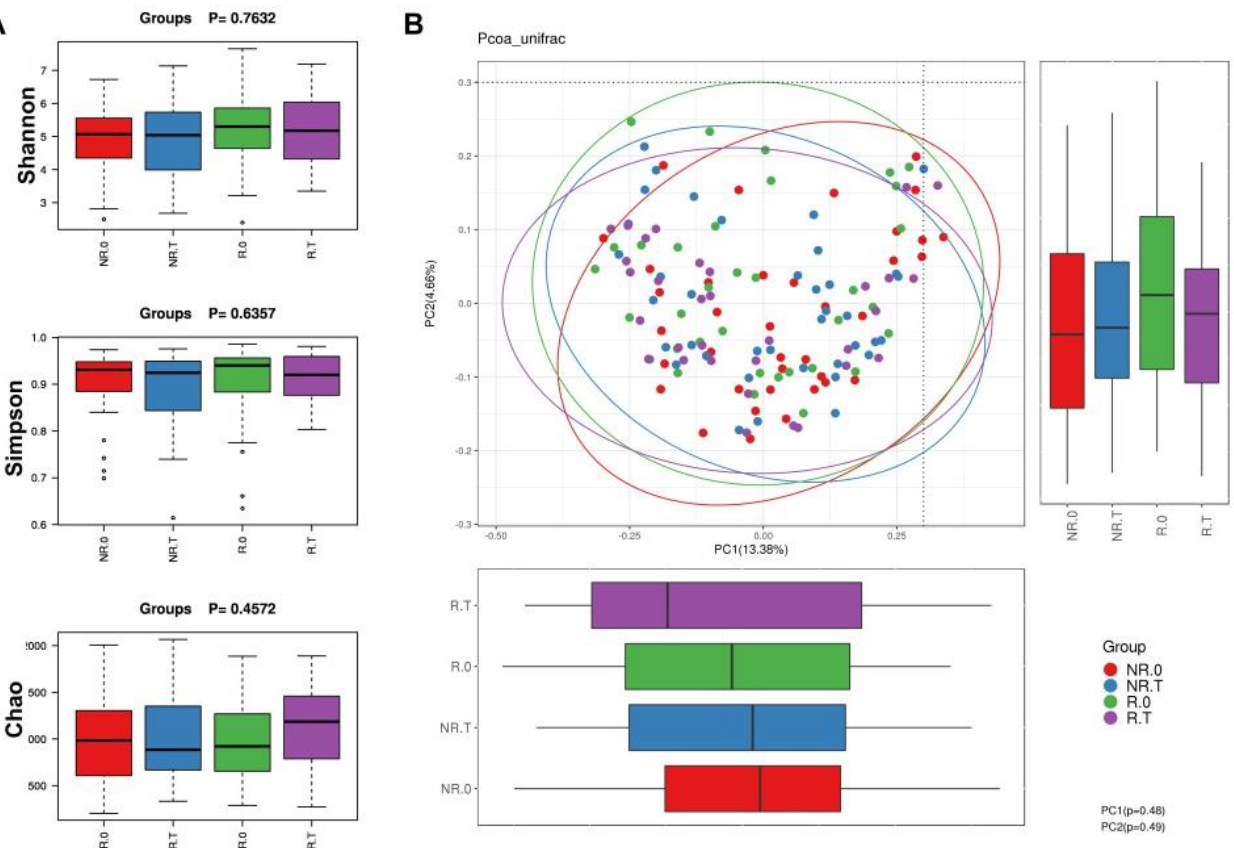
Figure 2. α − diversity index and PCoA results in four groups. ( A ) α − diversity index in each group. Figure 2. α− diversity index and PCoA results in four groups. ( A ) α− diversity index in each group. ( B ) PCoA with unweighted UniFrac ( B ) PCoA with unweighted UniFrac distances.